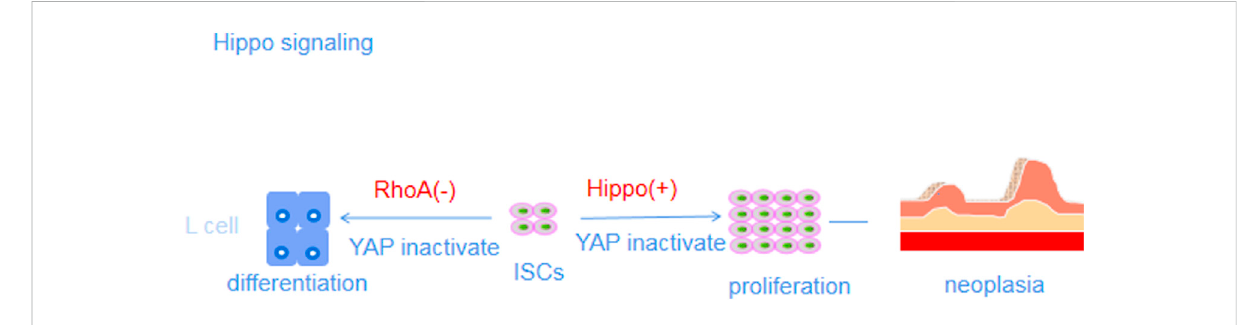
FIGURE 5 Mechanisms of action of Wnt/ β -catenin signaling